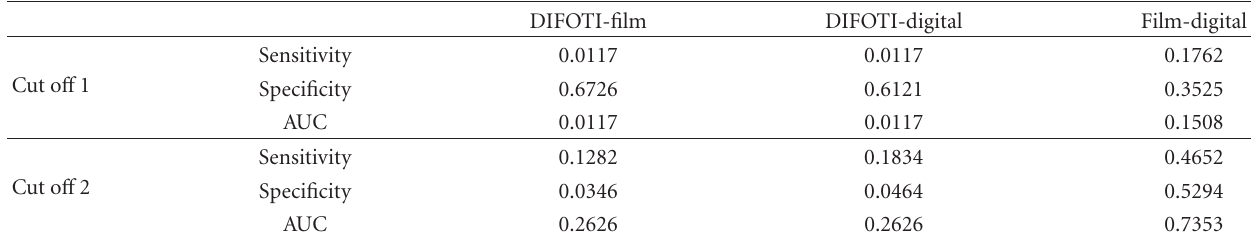
Table 3: Comparison of methods by Wilcoxon matched pairs test. The table presents P